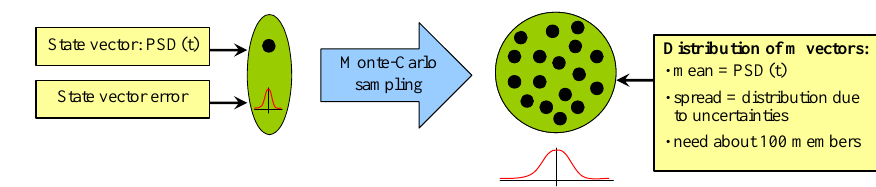
Fig. 5. A schematic view of the equivalence of the Kalman filter and the ensemble Kalman filter.